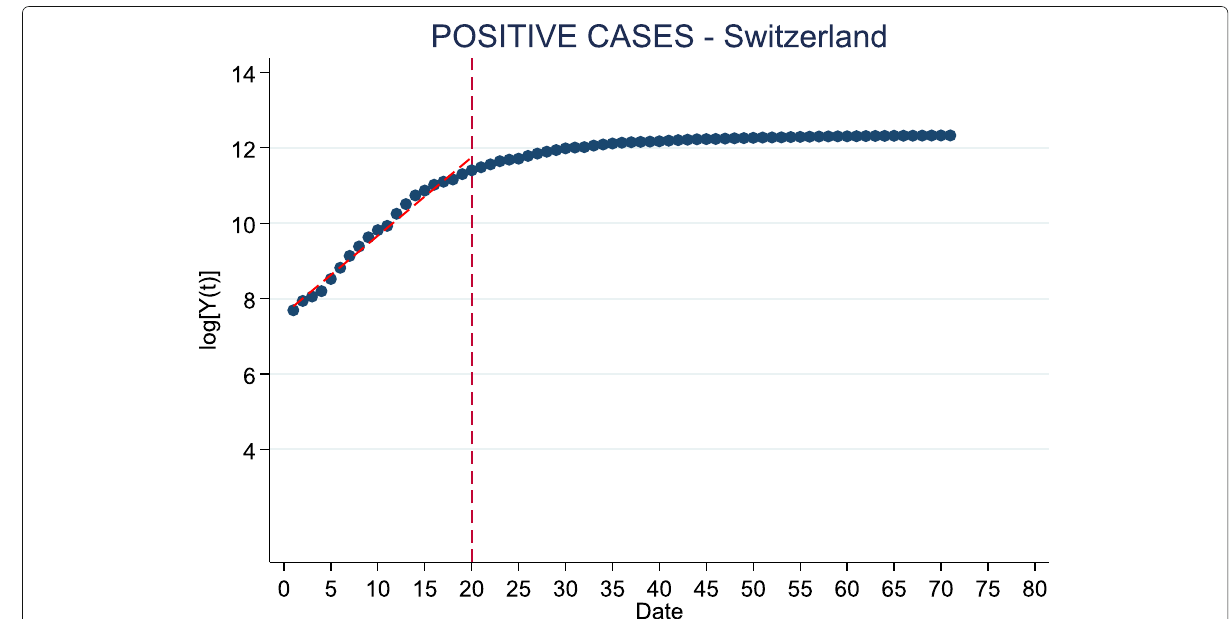
Fig. 1 (Log) number of cumulative positive cases. Note: This figure shows the evolution over time of the logarithm of the cumulative number of infections after March 5. The number of cases represented here is the one obtained after adjusting the official number of reported cases in light of the seroprevalence estimates by Stringhini et al. (2020). The change in the slope which occurs around the 20th day reflects the end of an exponential growth of cases thanks to the implementation of restrictive measures in the